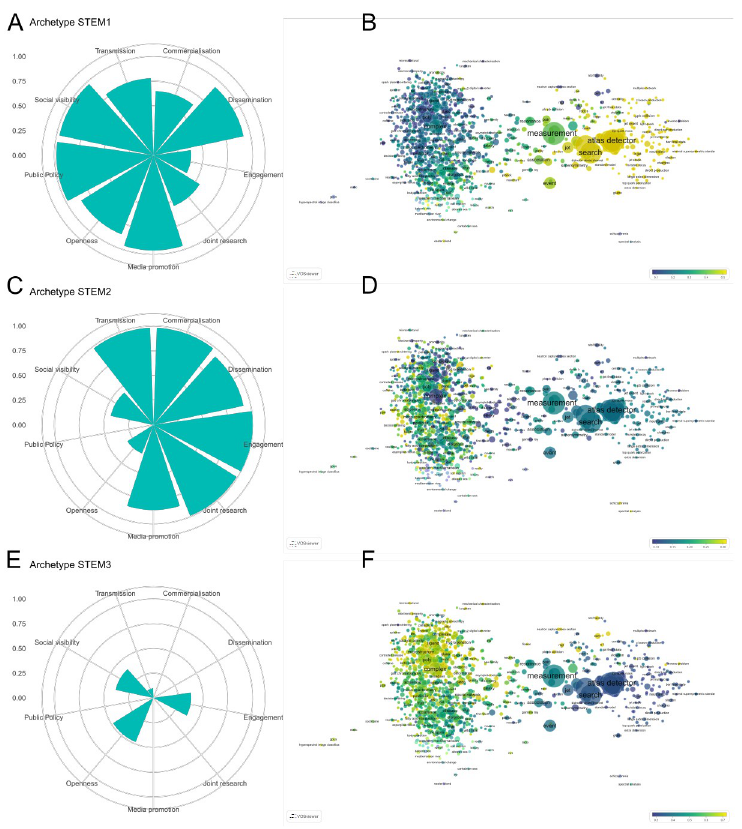
Fig 4. Parameters and topic maps for three archetypes in STEM field. Archetypes that emerge for all STEM cases (A, C and E), along with overlay maps of α scores corresponding to words included in the titles of research publications (B, D and F). Archetype parameters are shown in percentiles. Words follow a colour grading based on their maximum or minimum value, the extreme values being yellow (for those present in publication titles of cases resembling a given archetype) and blue (those which are not present in the publication titles of cases resembling the archetype). An online version of this map is available at: http://sl.ugr.es/stemarchetypes.